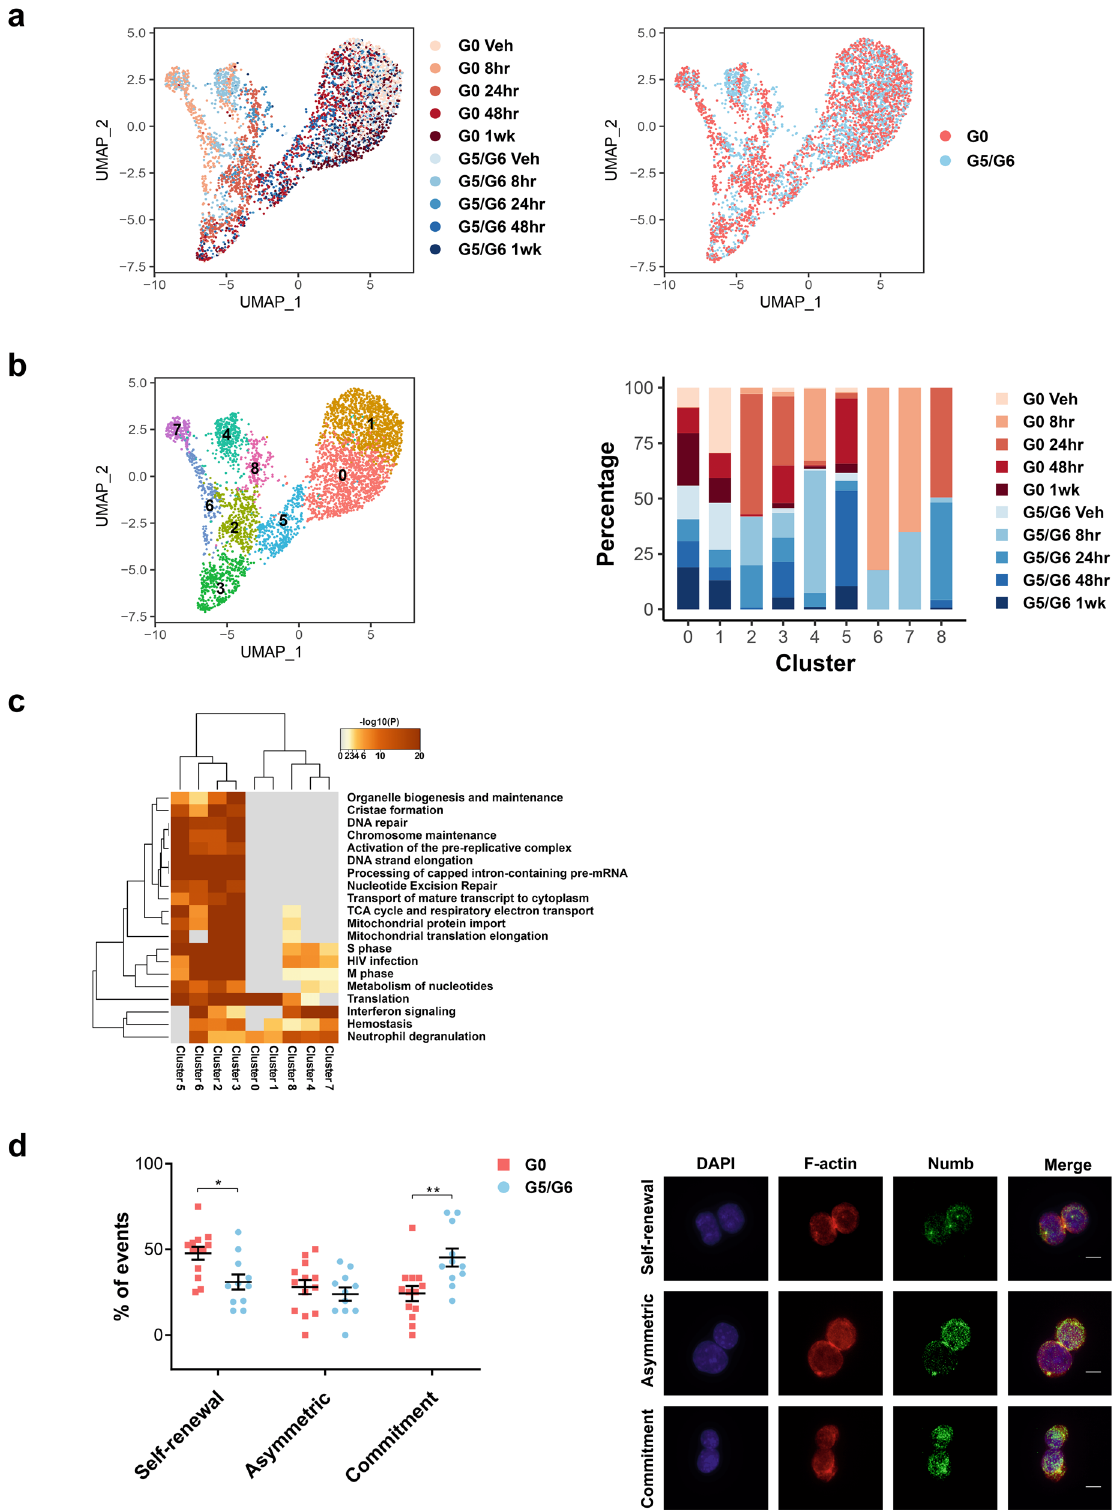
which had the highest level of Vwf expression) (Supplementary Fig. 9g and Supplementary Dataset 9). Further